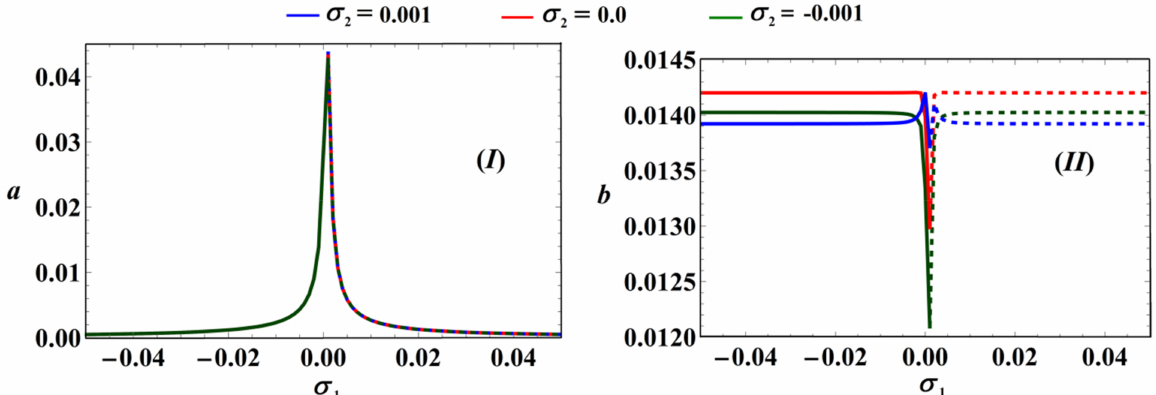
Figure 22. The frequency response of: ( I ) a ( σ 2 ) and ( II ) b ( σ 2 ) when σ 1 = 0, c 1 = 0.001, and c 2 = 0.011.